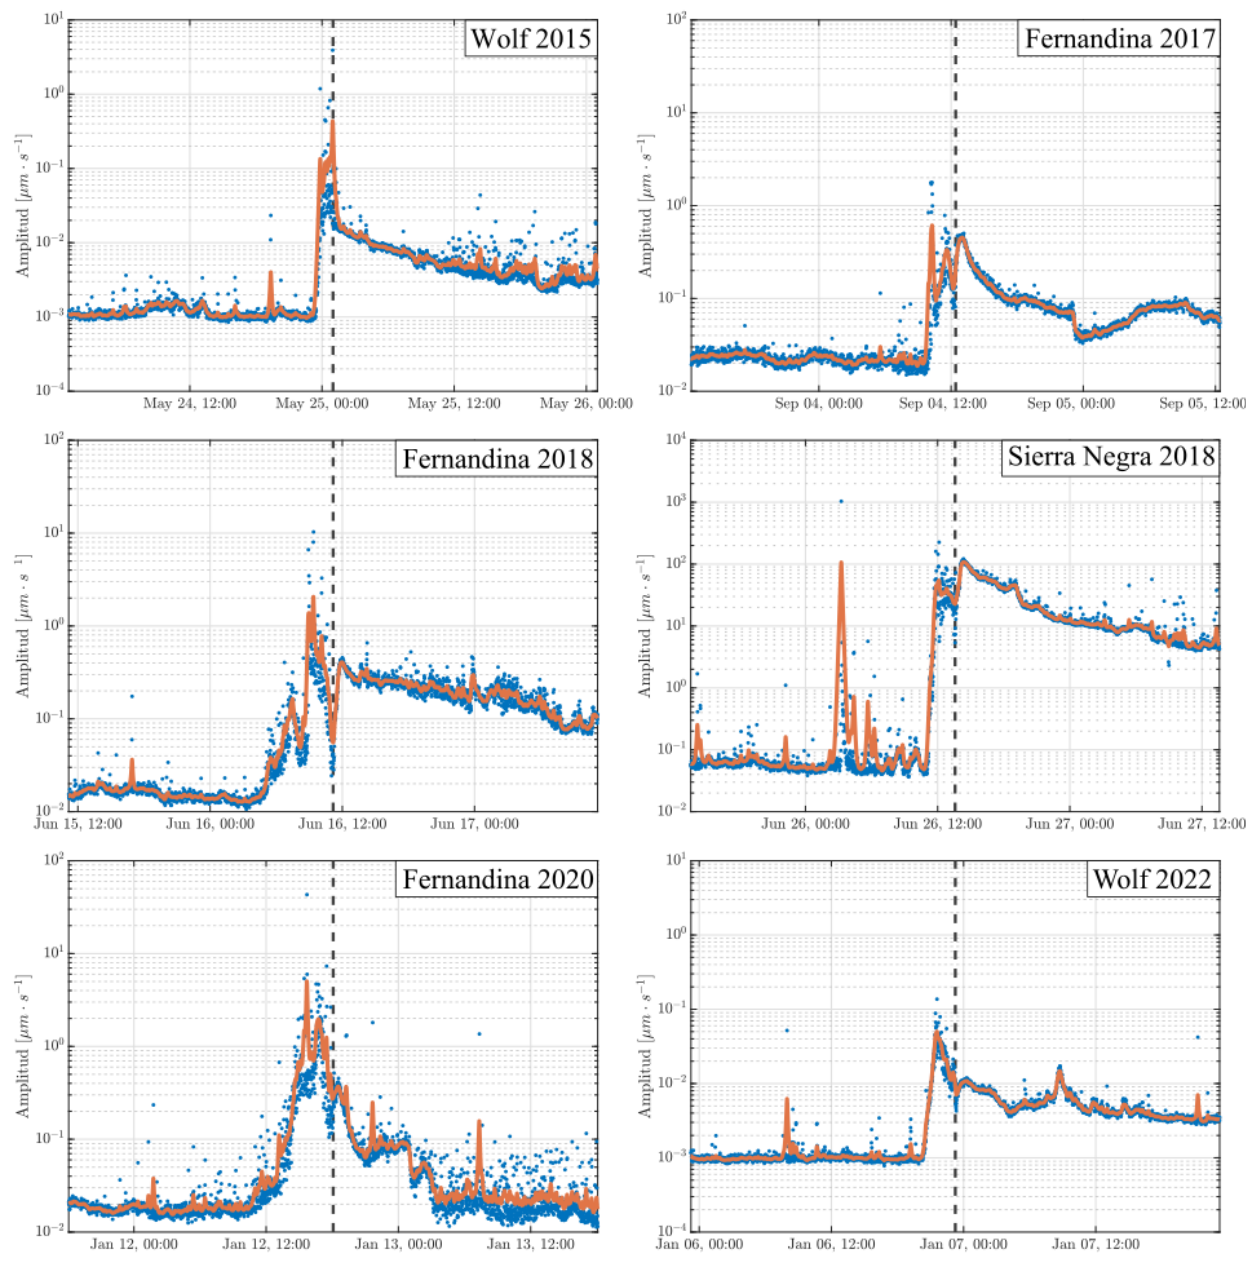
Figure 3: Selected seismic records of recent eruptions of Galápagos volcanoes. Blue dots correspond to the mean of absolute amplitude for a 60 seconds window length and orange line to a 30 minute average. Filtering of the seismic signal to avoid seismic noise mostly depends on the distance between the eruption site and the seismic station. Wolf 2015 and 2022 were recorded at FER1 seismic station (~33 km) and filtered between 5 and 7 Hz. Fernandina 2017 was recorded at FER2 (~15 km) seismic station and filtered between 2 and 8 Hz. Fernandina 2018 and 2020 were recorded at FER1 seismic station (~13 km) and filtered between 2 and 8 Hz. Sierra Negra 2018 was recorded at VCH1 (<1 km) seismic station and filtered between 0.5 and 16 Hz. The vertical dotted lines indicate the onset of the